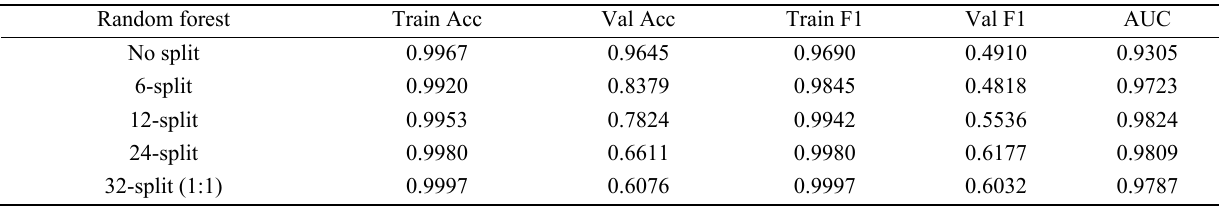
Table 11 Algorithm performance of RF using different splitting strategies (910 control variables). Random